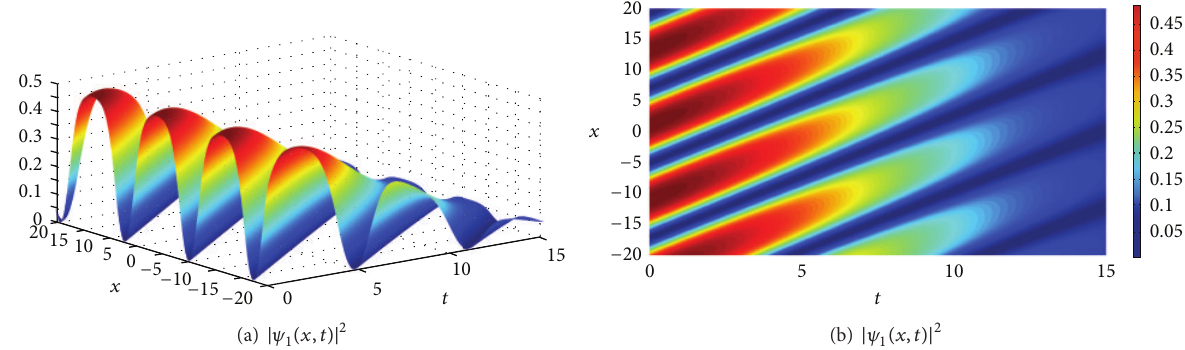
Figure 1: Density distributions of the matter-wave soliton solution 𝜓 1 (𝑥,𝑡) : (a) the three-dimensional density distribution and (b) the contour profile.